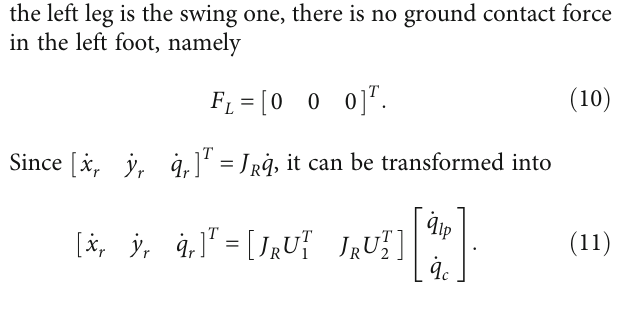
Þ and ð x , y , q , y , l r l l r